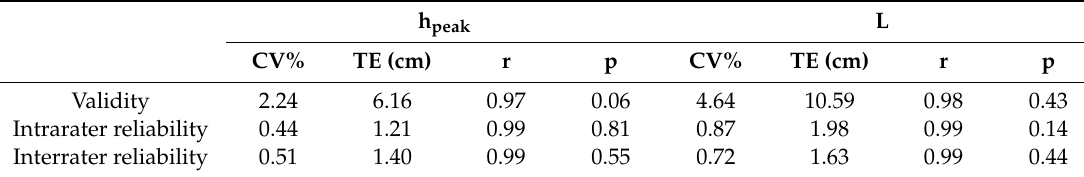
Table 2. Random error (CV%), typical error (TE), correlation coe ffi cient, and systematic error (p) of peak height (h peak ) and length of flight (L) of vauls, when comparing first 2D video analysis (2D 1 ) evaluations to 3D motion capture (validity) and to second 2D analysis (intrarater reliability), as well